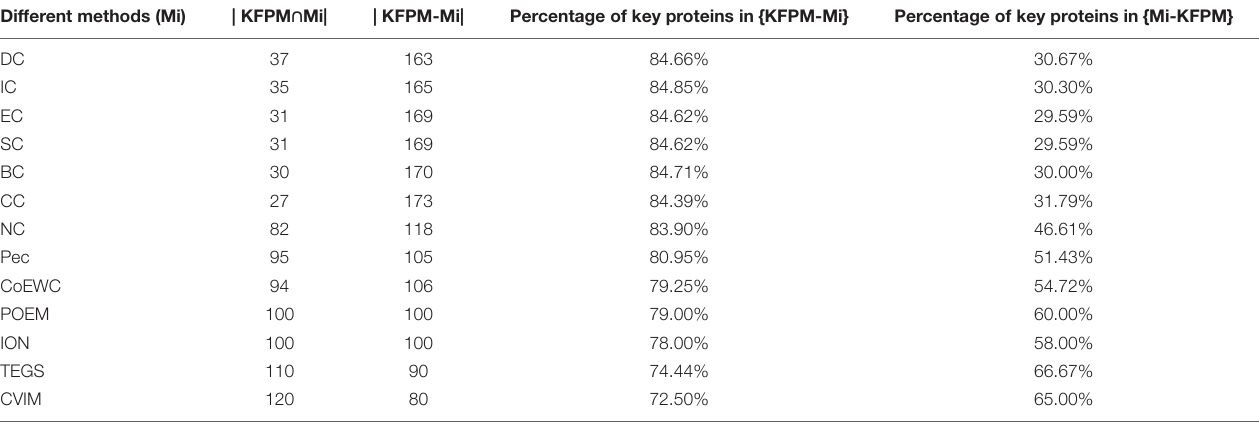
TABLE 2 | Commonalities and differences between KFPM and 13 competitive methods based on top 200 ranked proteins under the DIP database. Different methods (Mi)